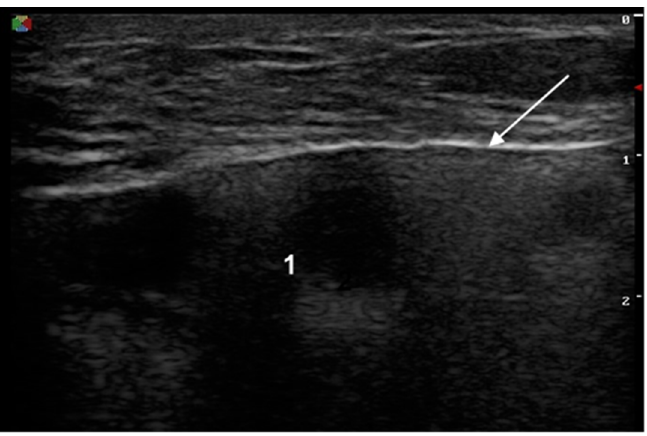
Figure 2. Signs of a ruptured implant on ultrasound: white arrow—abnormal shell (one white line is visible); 1—inhomogeneous content.